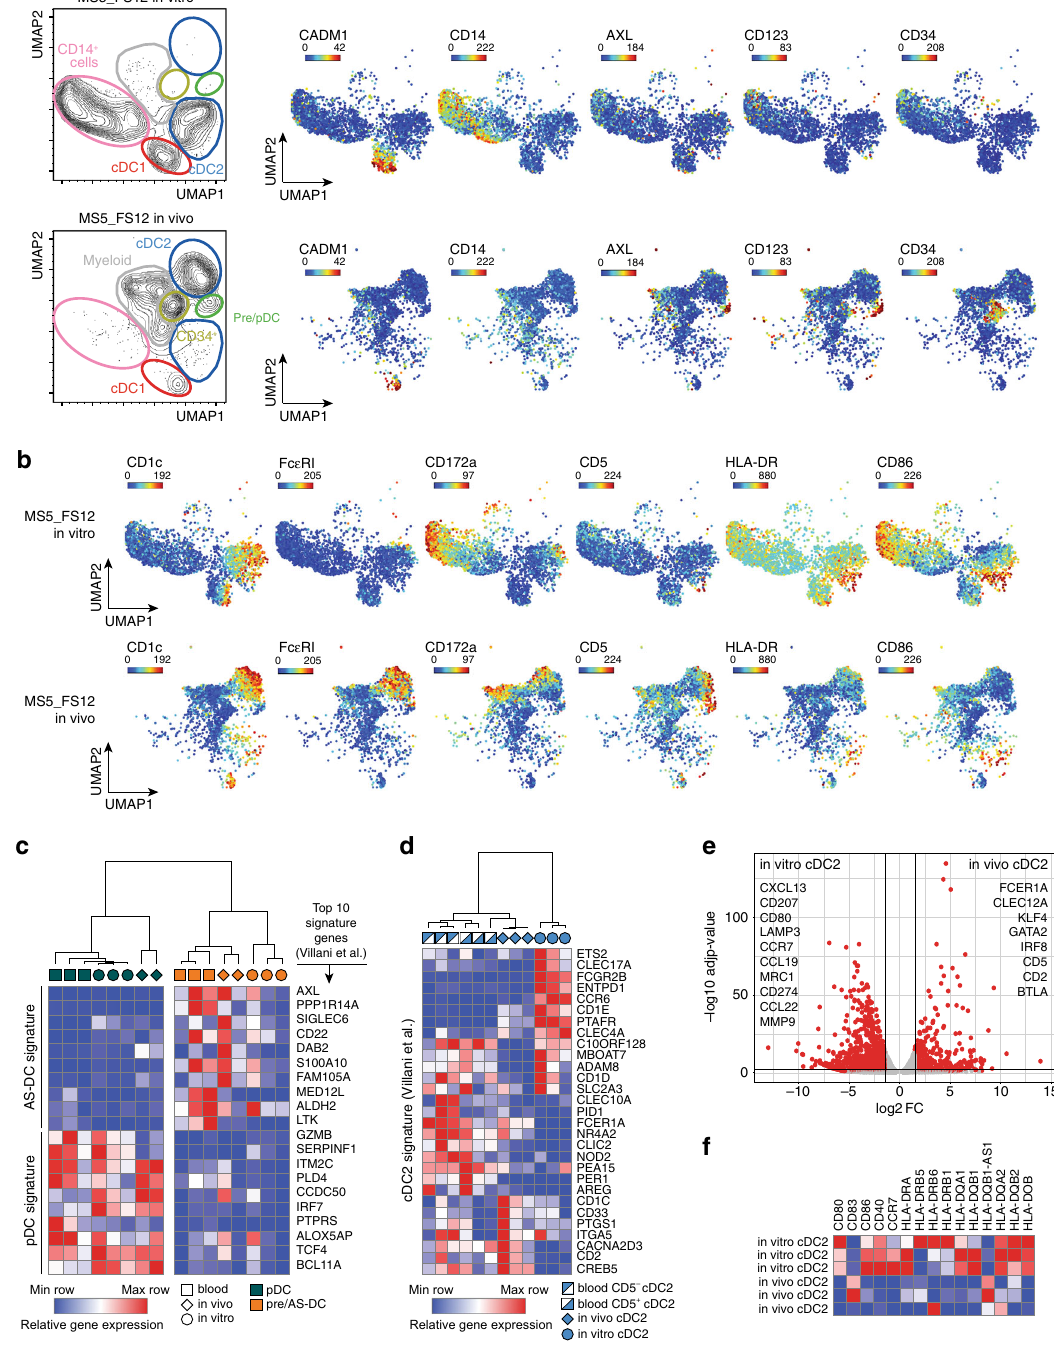
Fig. 7 cDC2 generated in vivo faithfully align to blood cDC2. a UMAP plots of CyTOF data comparing CD45 + HLA-DR + cells generated using MS5_FS12 stromal cells either in vitro or in vivo. Relative expression of selected markers is shown for each condition. b Relative expression of selected markers highlighting the phenotypic differences between cDC2s generated in vitro and in vivo using MS5_FS12 stromal cells. c Heatmap displaying gene expression of the top ten genes of blood pDC and AS-DC published signatures 20 in pDC and pre/AS-DC generated in vitro, in vivo, and isolated from blood PBMC ( n = 2 independent donors for pDC and pre/AS-DC generated in vivo and n = 3 independent donors for pDC and pre/AS-DC generated in vitro or isolated from peripheral blood). d Heatmap displaying gene expression of the blood cDC2 published signature 20 in cDC2 cells generated in vitro, in vivo and isolated from blood PBMC ( n = 3 independent donors). e Volcano plot showing differentially expressed genes between in vitro and in vivo generated cDC2 (Log2FC > 1.5, adjusted p -value < 0.05). Statistical signi fi cance was calculated using Wald test with a Benjamin – Hochberg p -value correction ( n = 3 independent donors per group). f Heatmap displaying gene expression of activation markers and co-stimulatory molecules expressed in cDC2 generated in vivo and in vitro ( n = 3 independent